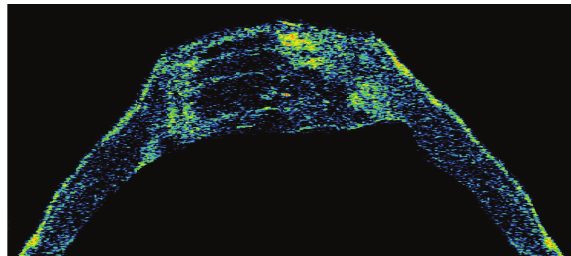
Figure 2: Horizontal OCT-scan displays a logarithmic false-colors image of the entire cornea OD composed of 7 images. Each OCT- scan has length of 4.07 mm represented by 100 columns and a depth of 1500 µ m represented by 300pixels. OCT determined the cornea as a hyporeflective band in light greenish colors. While the lateral cornea has a normal thickness and appears steepend, the central cornea in a diameter of approximately 7.5 mm has a flatt curvature with an intrastromal low reflectivity, consistent with a severe intrastromal edema of approximately 1250 µ m.